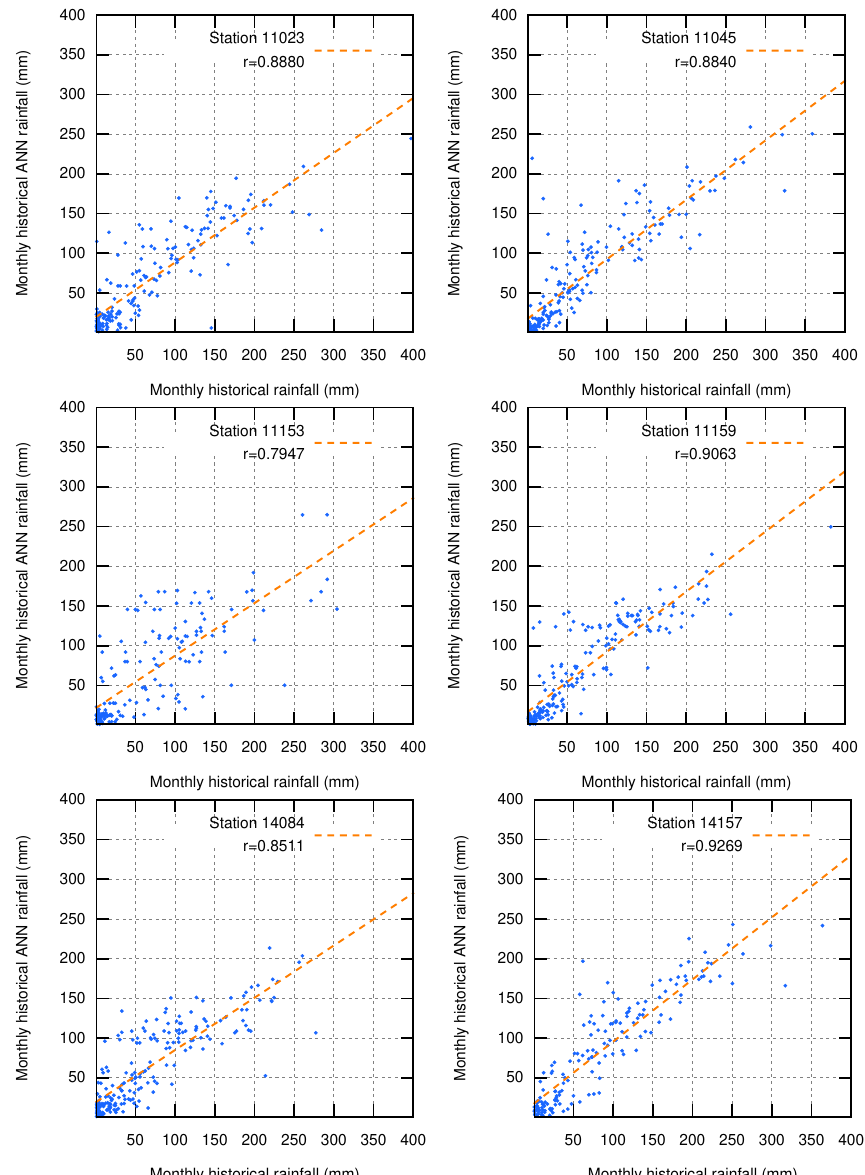
Figure 5. Examples of correlations ( R ) showing the efficiency obtained by the ANNs in the training